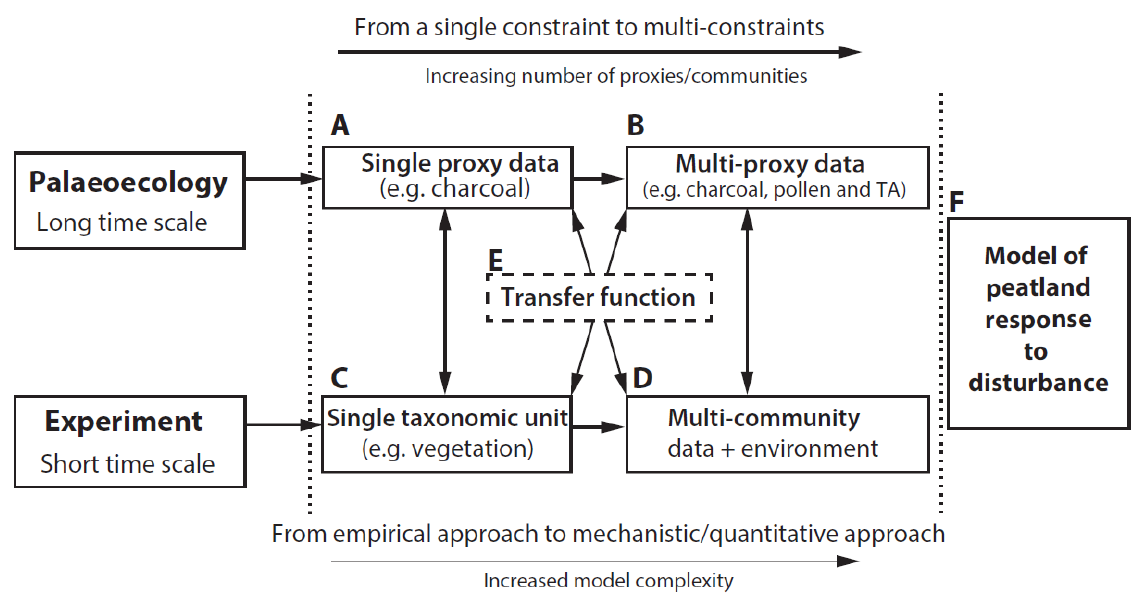
Figure 10. A concept for linking palaeoecological and experimental approaches. The diagram shows an increasing complexity of the palaeoecological information/record from one proxy to multiple proxies, paralleled by an increasing complexity in experiments on population to communities. As the number of dimensions of datasets increases, the complexity of models based on transfer functions also